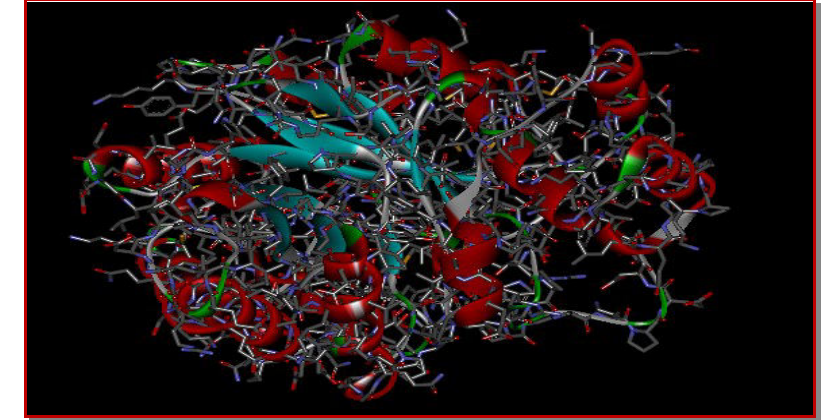
Figure 1: Aldose reductase enzyme from RCSB